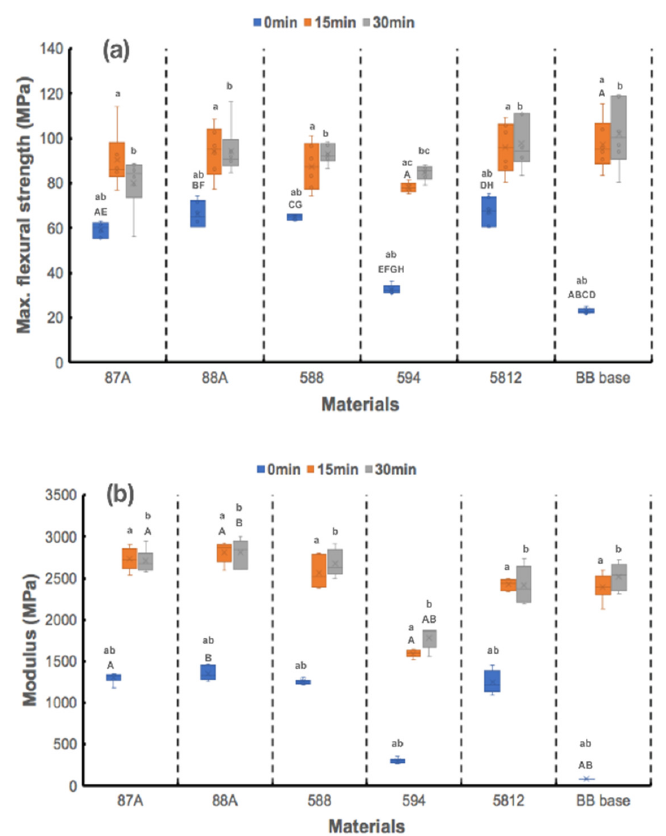
Figure 5. ( a ) Flexural strength and ( b ) flexural modulus of 5 urethane acrylate (UA)-based photo- polymer resins and a BB base. Same capital letter indicates static difference between materials for each UV-exposure period; same small letter indicates static difference between UV-exposure peri- ods for each